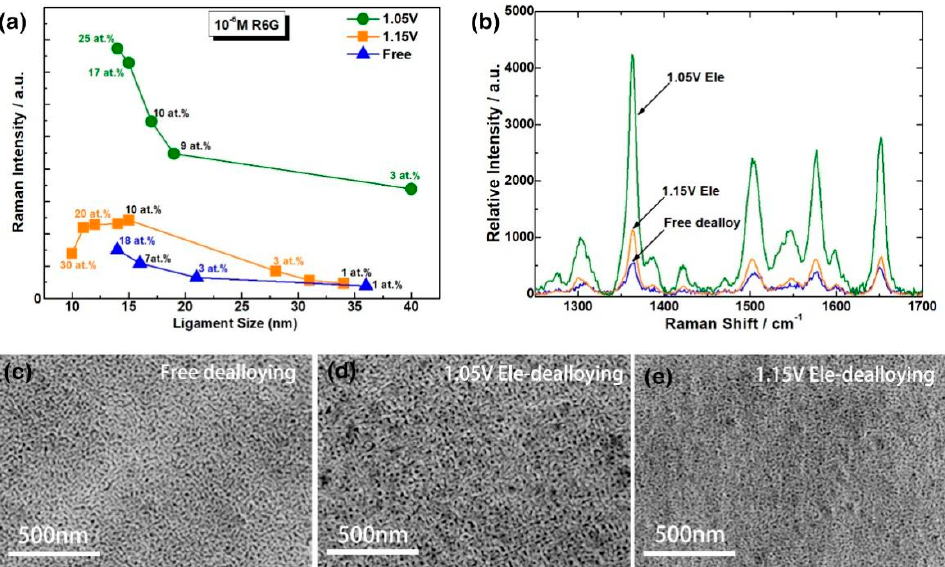
Figure 2. SEM images and SERS spectra of NPG with similar ligament size and residual silver that prepared at different conditions. ( a ) Pore size dependences of the Raman intensities, and the number near the data dots are the residual silver concentration after dealloying. ( b ) SERS spectra of selected three samples. SEM images of the three samples ( c ) NPG-Free, ( d ) NPG-1.05 V Ele, and ( e ) NPG-1.15 V Ele.